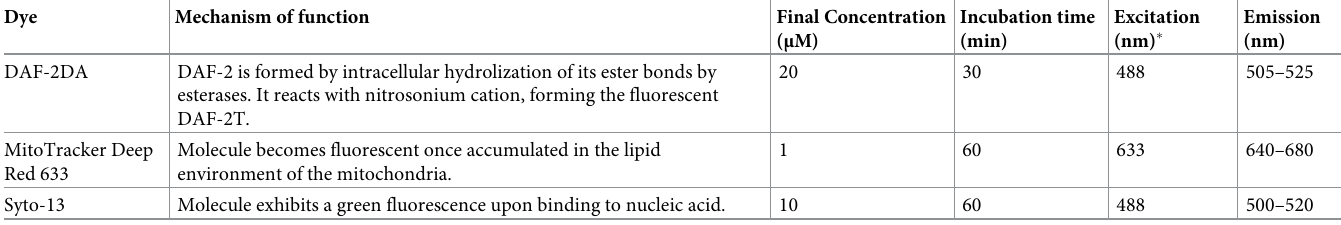
Table 1. Analysis conditions for the individual dyes. Table 1) and a 40x optical objective. Each gill filament was placed onto a microscope slide with 200 μ l incubation medium of the respective p O and imaged within a few seconds. In order to 2 locate the nuclei and the mitochondria in the gill filaments (Fig 2A1 and Table 1) and localize the tissue structures centrally involved in NO-formation, additional gill pieces were stained with SYTO-13 (Molecular Probes S7575, 5 mM in DMSO) and Mitotracker Deep Red 633 (Molecular Probes M-22426, 1 mM in DMSO). To avoid photo-bleaching, an initial short period ( > 5 sec) of low-resolution scanning (512 x 512 pixels) was applied for focal adjust- ment. Then, for image analysis and NO fluorescence quantification, a minimum of five scans with higher resolution (1024 x 1024 pixels) were conducted across the surface of each gill piece. For each of the scans taken, a total of three square cross sections (= regions of interest, ROI) were plotted across the gill filaments (Fig 2A2) in the layer with the highest fluorescence intensity, which was 5 μ m above the z-depth containing the blood vessel (Fig 2B). The fluores- cence intensity of each ROI was quantified using the Leica LAS AF-TCS-SPS Lite software (Leica Microsystems CMS GmbH, 2011, Version 2.6.0) and the average NO formation over time was calculated as the average DAF-2T fluorescence intensity ratio between hypoxic and control pO (6:16 kPa and 2:16 kPa) after 15–20 min, 30–35 min, 45–50 min. 2